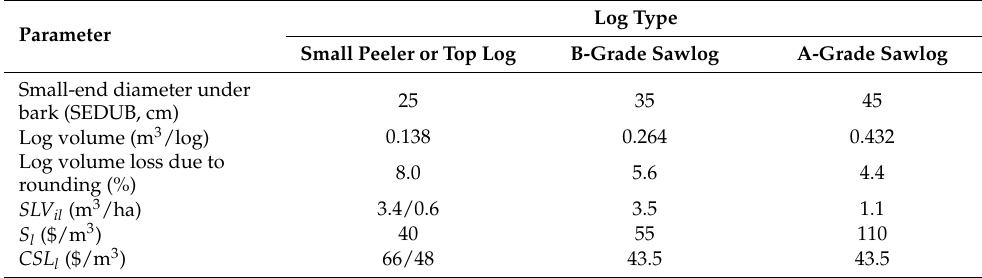
Table 3. Log and harvest cost